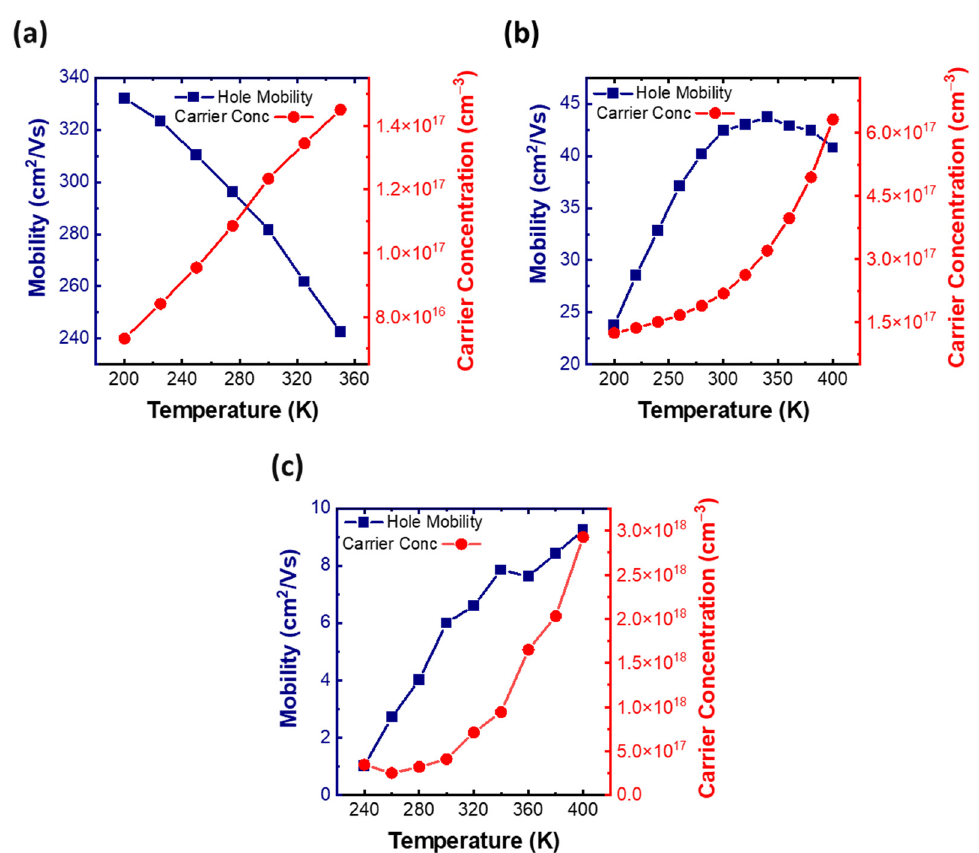
Figure 4. Carrier mobility and concentration of ( a ) 250 nm GaSb on a SI GaAs substrate, ( b ) 250 nm GaSb on a Si/SiO 2 substrate, and ( c ) 50 nm GaAs + 50 nm GaSb on a Si/SiO 2 substrate.